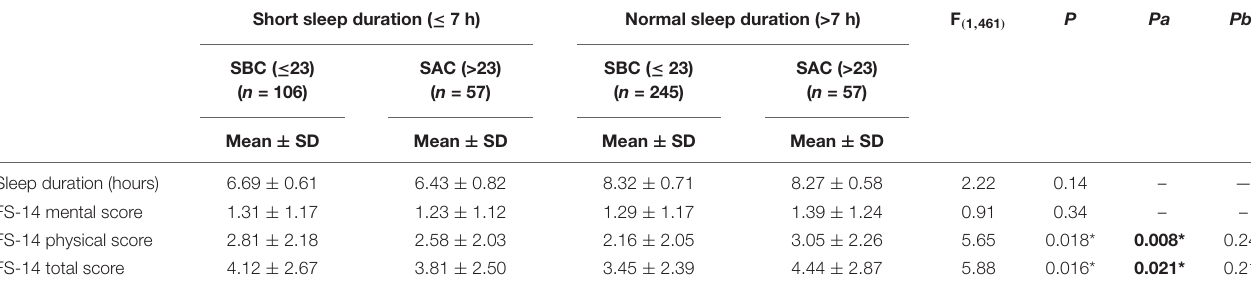
TABLE 2 | Comparison of the 14-item Fatigue Scale (FS-14) scores between short sleep duration and normal sleep duration groups in the third trimester of